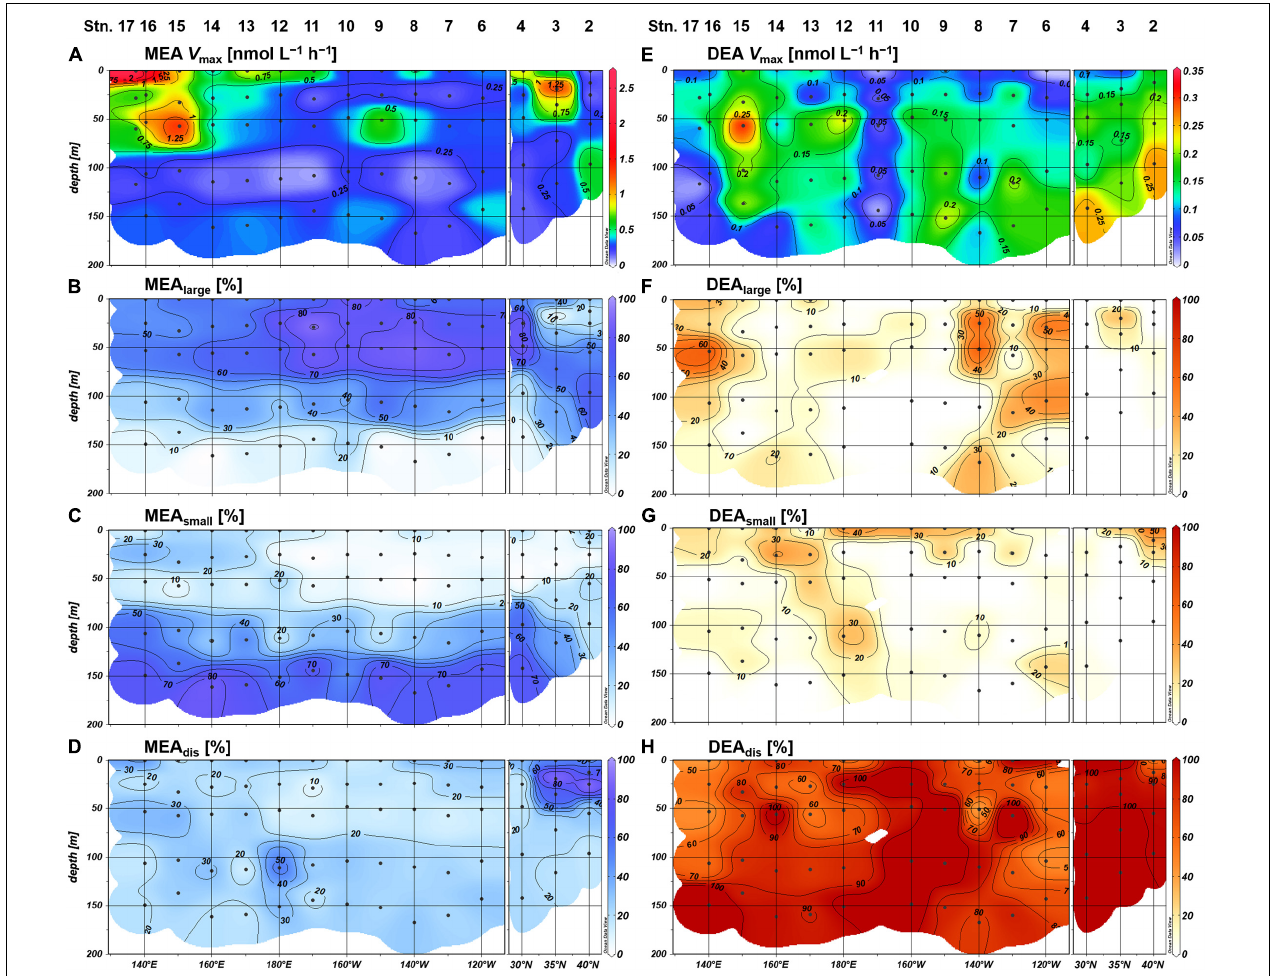
FIGURE 8 | Distributions of monoesterase activity (MEA), diesterase activity (DEA), and the proportion of size-fractionated enzyme activities; (A,E) bulk enzyme activities in whole seawater samples, (B,F) enzyme activities in large size fraction ( > 0.8 µ m), (C,G) enzyme activities in small size fraction (0.2–0.8 µ m), and (D,H) enzyme activities in the dissolved fraction ( < 0.2 µ